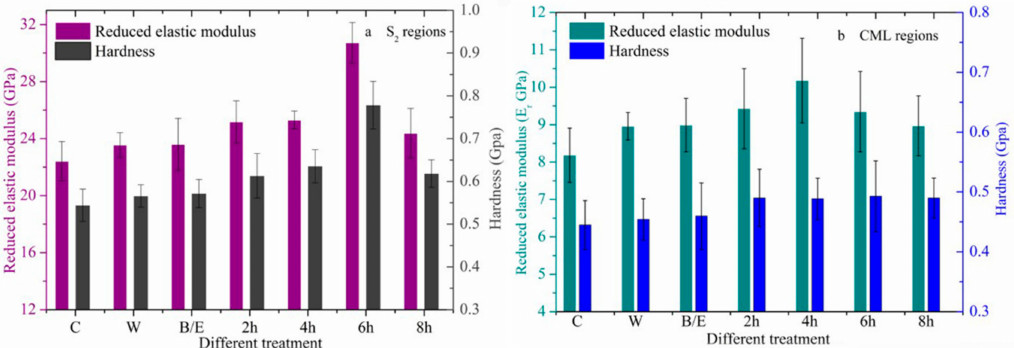
Figure 5. Changes in the mechanical properties of cell walls with alkali gradient treatment. (( a ): S 2 regions; ( b ): CML